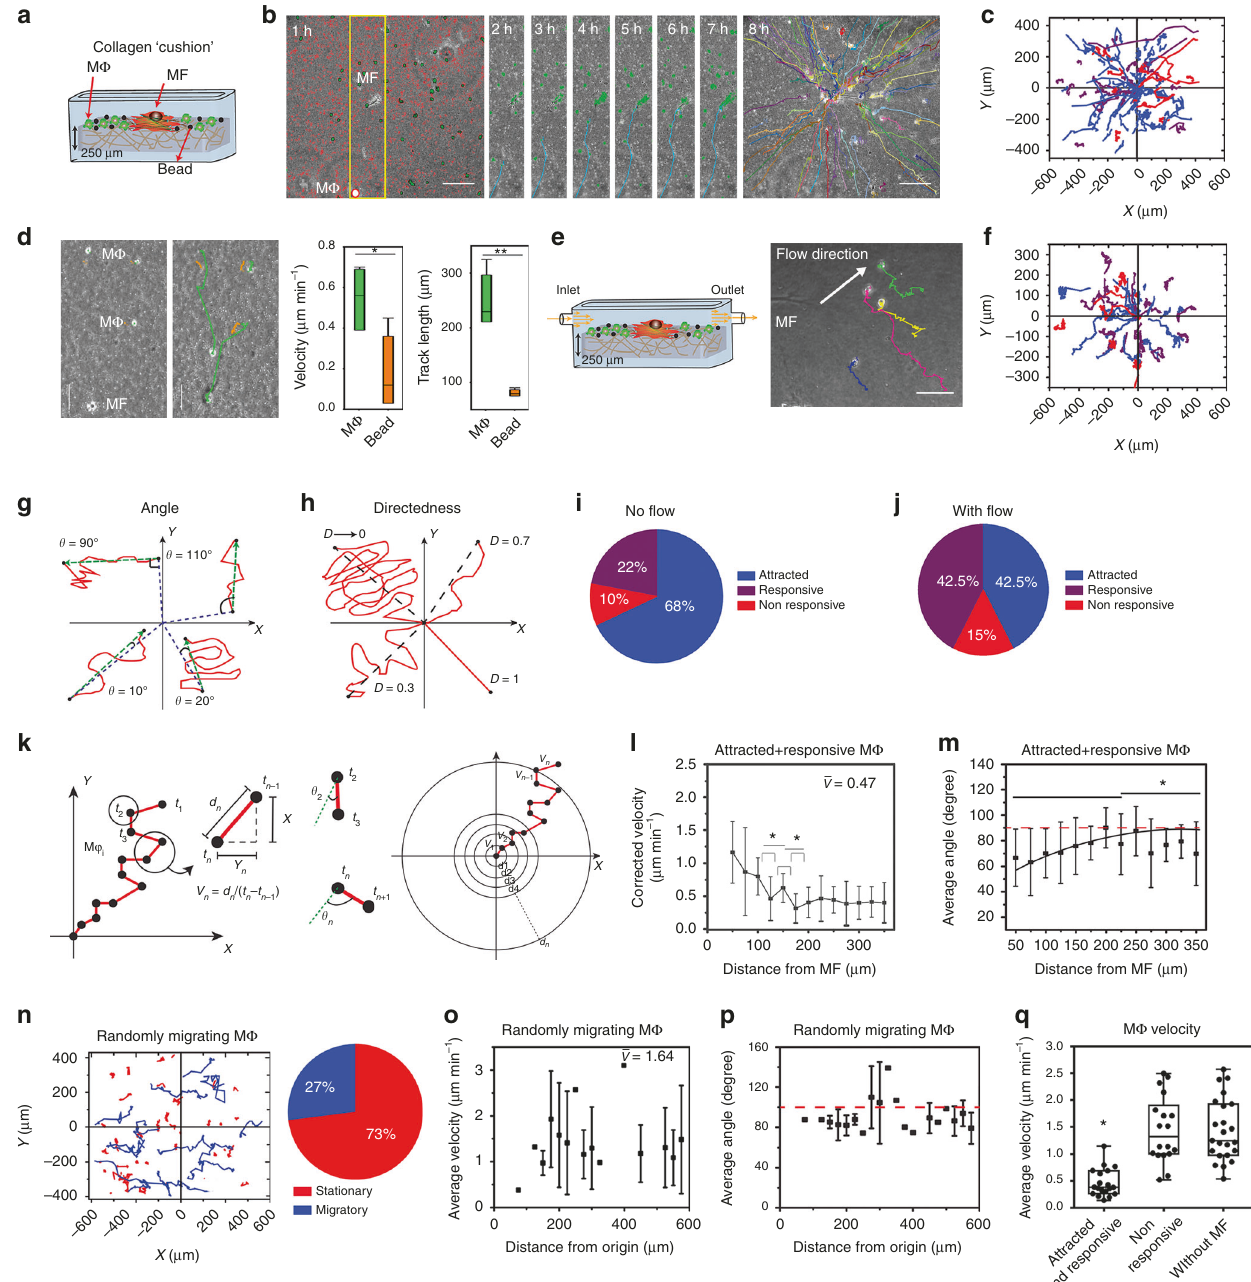
Fig. 2 Macrophages (M ϕ ) are attracted to myo fi broblast (MF) on fi brillar collagen extracellular matrix (ECM). a M ϕ were co-cultured with MFs on top of fi brillar collagen ECM with surface marker beads and b recorded for 8 h at one frame per 5 min. M ϕ (green colored) and beads (red colored) were automatically tracked in phase-contrast videos. c M ϕ tracks (blue-attracted M ϕ , purple-responsive M ϕ , red-non-responsive M ϕ ) were plotted with respect whisker (minimum to maximum) plots with center lines showing medians (20 experiments with average 5 image fi elds, * p ≤ 0.05 and ** p ≤ 0.01, Student ’